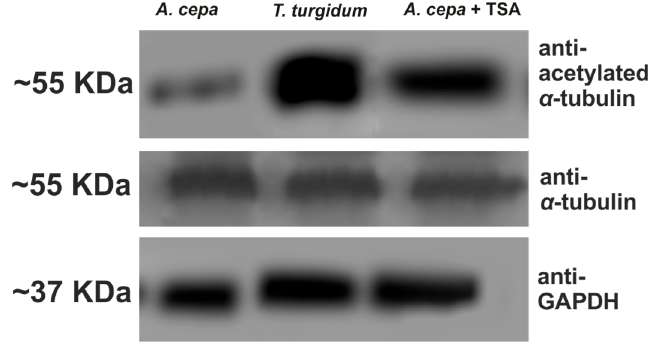
Figure 8. ( A – H ) Acetylated α -tubulin immunolocalization (green) and ( B – H ) propidium iodide DNA staining (red) in untreated root cells. The inset in ( E ) depicts the interphase nucleus of the cell. All images are single CLSM sections. Scale bar: 10 μ m.